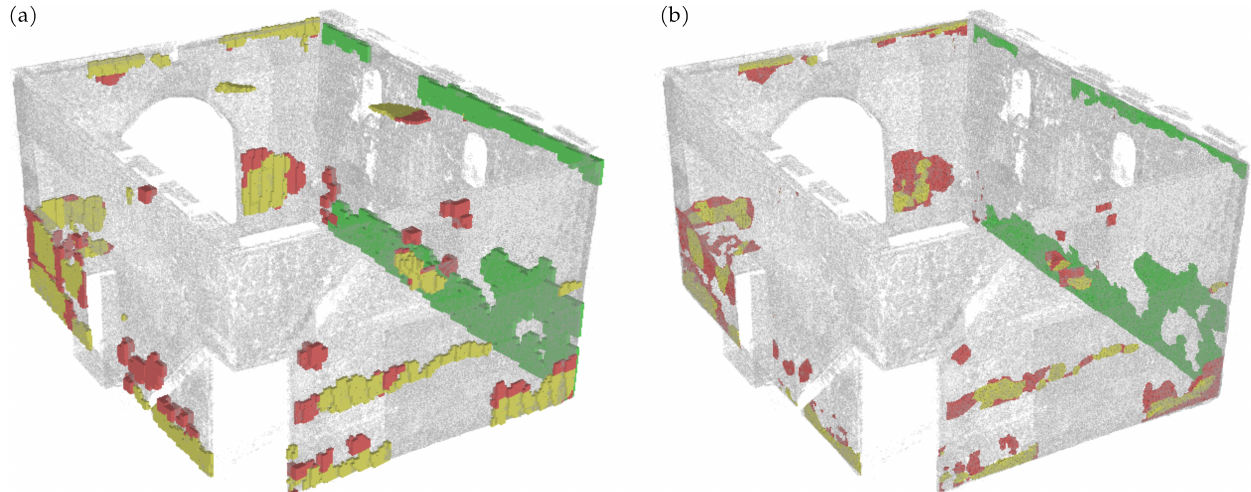
Figure 15. Three-dimensional view of the voxelised and compared full annotation dataset (compari- son of t 2 and t 3 ) in two variants with ( a ) a rough computation using d v = 5cm and r v = 1 and ( b ) a more detailed computation using d v = 0.5cm and r v = 4 (red: new damaged regions, yellow: regions already identified in t 2 , and green: repaired or not re-identified